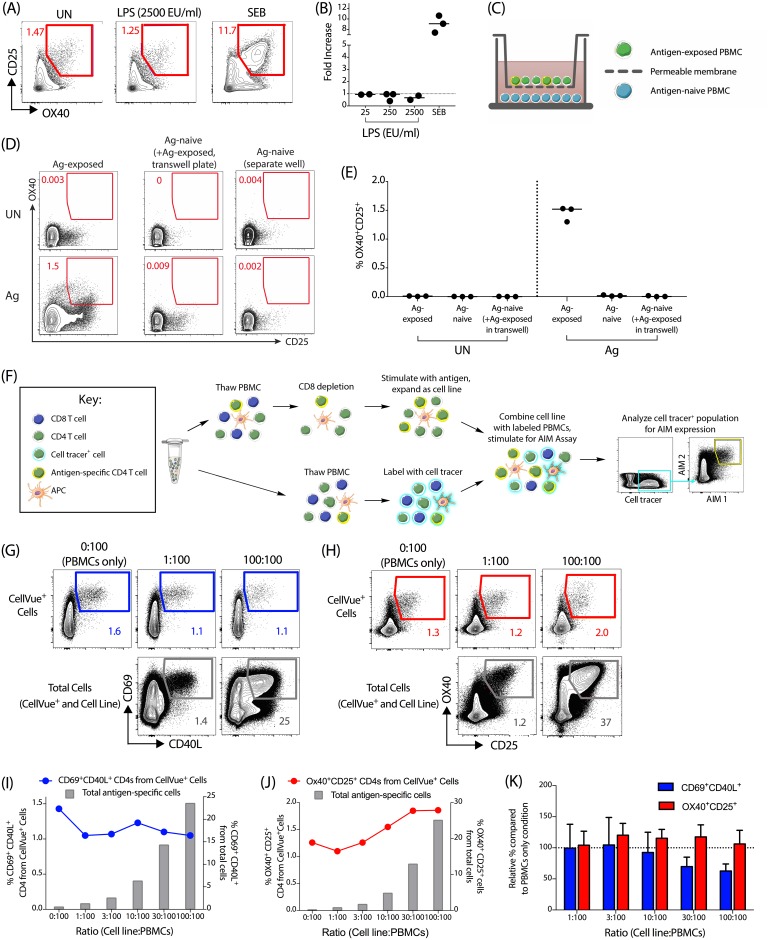
Bystander activation by contaminants or non-TCR stimulation has limited impact on upregulation of AIM markers.(A,B) OX40/CD25 expression of PBMCs cultured in the presence of increasing amounts of LPS (25–2500 EU/ml), with an unstimulated (UN) and SEB condition as negative and positive control. (A) Example plots from a representative donor cultured with or without LPS. (B) Data shown as fold-increase (LPS/UN); n = 3 donors. (C) Experimental setup for transwell plate experiment, where antigen-exposed PBMCs were placed within the top well of a transwell plate, and antigen-naïve PBMCs were placed within the bottom well, with the two wells separated by a 0.4 μm pore-size permeable membrane. The cultures were then left unstimulated (UN) or stimulated with antigen (Ag) for 24 hours at 37°C. (D) Representative flow cytometry plot of the antigen-experienced PBMCs in the top well of the transwell plate (left column), the antigen-naïve PBMC in the bottom well of the transwell plate (middle column), and the antigen-naïve PBMC control in a separate plate (right column) after 24 hours in culture; with the unstimulated condition (UN) on the top row and antigen stimulated (Ag) on the bottom row. Gated on total CD4 T cells. (E) Quantification of the OX40+CD25+ signal for the three culture conditions, unstimulated (UN) or stimulated with antigen (Ag). n = 3 antigen-naïve donors. (F) Diagram of the CD4 T cell line bystander activation experiment from panels G-K. Briefly, cell tracer-labeled (CellVue+) PBMCs were cocultured with an autologous CD4 T cell line at different ratios and stimulated with peptide antigens for 18 hr. (G,H) Example flow plots show the frequency of antigen-specific CD4 T cells CellVue+ PBMCs in the top row compared to the total frequency of antigen-specific cells within the coculture (CD4 T cell line + CellVue+ PBMCs) in the bottom row, at indicated ratios of CD4 T cell line and CellVue+ PBMCs. Antigen-specific cells are identified as CD69+CD40L+ (G) or OX40+CD25+ (H) respectively. (I,J) Quantification of data shown in (G,H) for CD69/CD40L (I) and OX40/CD25 expression (J) respectively. The total frequency of antigen-specific cells in the culture (CD4 T cell line + CellVue+ PBMCs) is indicated by grey bars; the frequency of CellVue+ autologous CD4 T cells from PBMCs is indicated by the colored dots/lines. (K) Data shown as a relative change in the percentage of antigen-specific CD4 T cells from the CellVue+ PBMCs at each ratio, compared to the PBMC alone condition. n = 3 independent experiments and donors, with HIV-Gag or hCMV pp65 peptide stimulation. Bars represent mean +/- SEM, dotted line at 100% (i.e. no change).